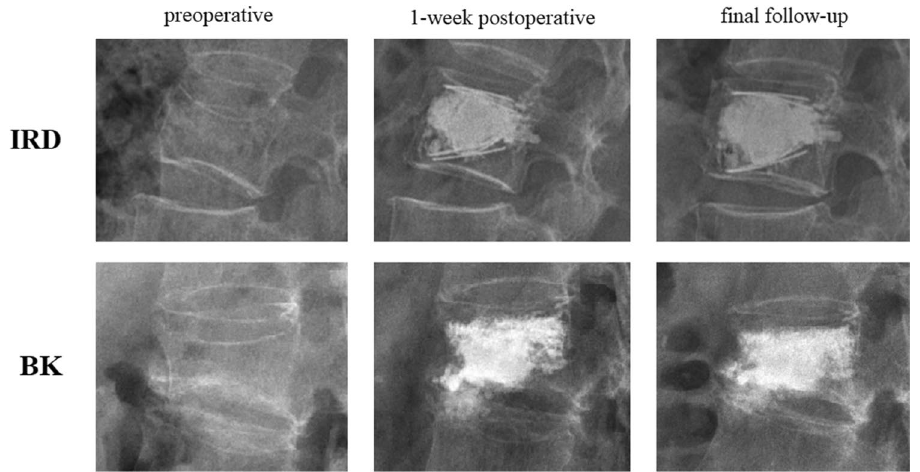
Figure 3. Radiographic demonstration of KP with IRD and BK: preoperative, 1-week postoperative, and final, respectively. ( KP with IRD kyphoplasty with intravertebral reduction device, BK kyphoplasty with